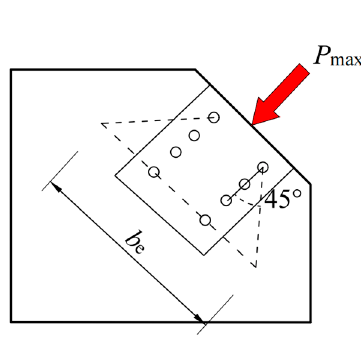
Figure 4. Effective width method [25].